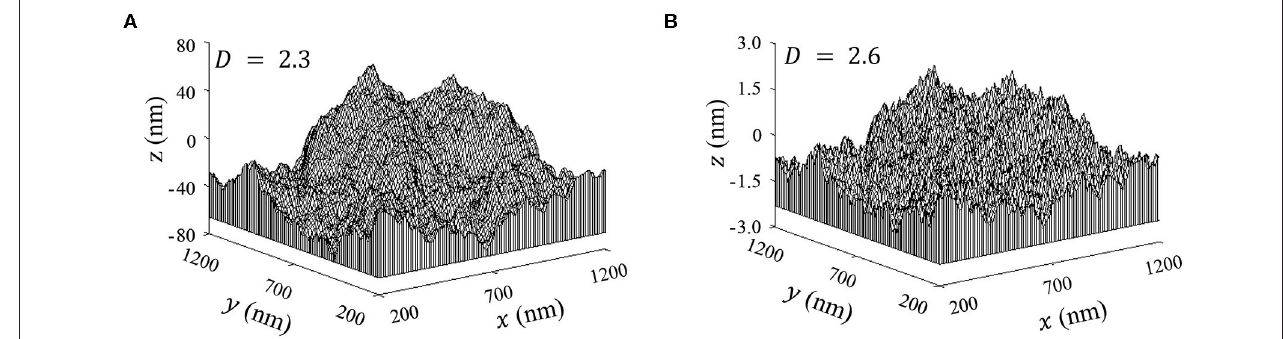
FIGURE 1 | Fractal surfaces generated from Equation (4) with G